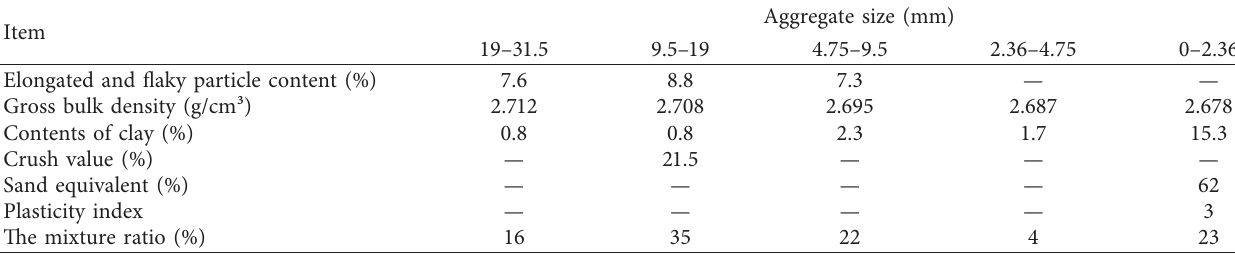
Table 2: Physical performances of aggregate [31].